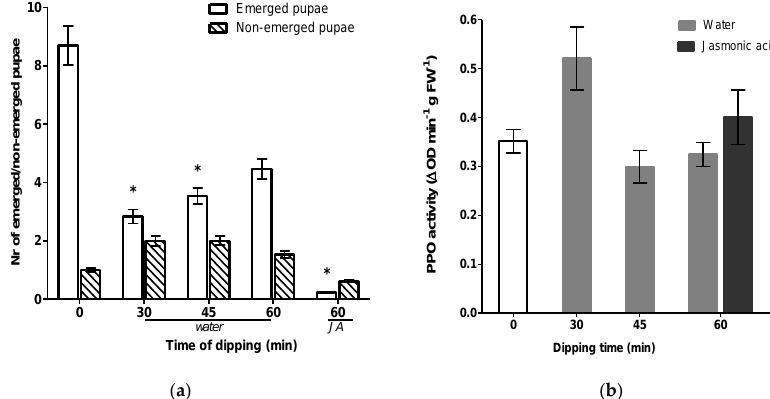
Figure 4. Effect of dipping on the leaf miner pupation and induction of polyphenol oxidase activity. Cut ends of chrysanthemum, pretreated with 0.4% IBA, were dipped in water for various durations and in a solution of 5 mM jasmonic acid for 60 min. Non-dipped cuttings, indicated at t = 0 in the graph, serve as a control. ( a ) Number of pupae emerging from chrysanthemum leaves and non- emerged pupae were scored after one week ( n = 13). Asterisks indicate statistical significance in comparison to non-dipped control cuttings determined by Welch’s t -test (* p < 0.05). ( b ) Polyphenol oxidase activity ( n = 8–10) was measured in the third leaf from the bottom prior to leaf miner infestation. Reciprocally transformed PPO data were analyzed by the Mann–Whitney test. Data shown are representative of means ± SEM.